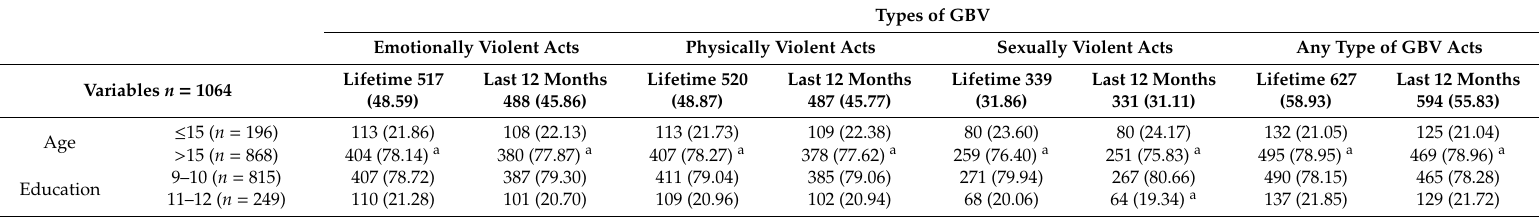
Table 3. Di ff erences in the GBV perpetration by educational level and